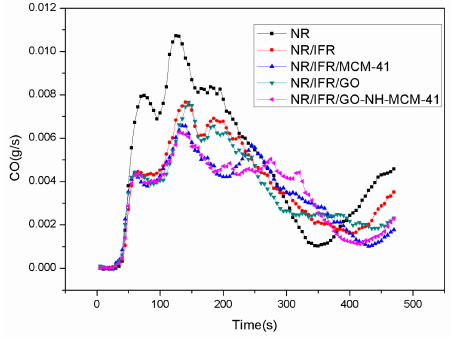
Figure 4. CO curves of FRNR